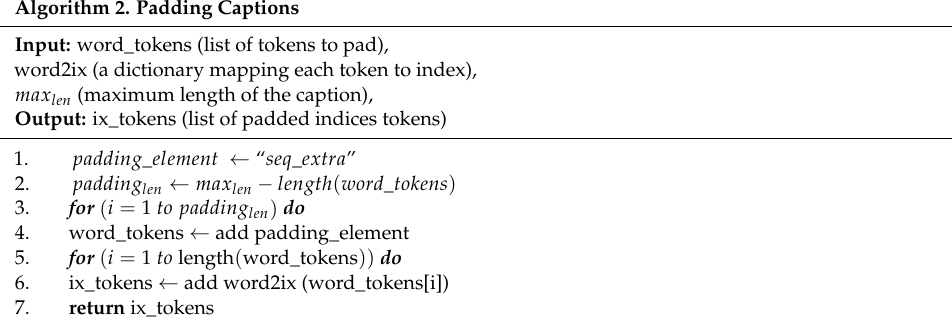
Algorithm 2. Padding Captions